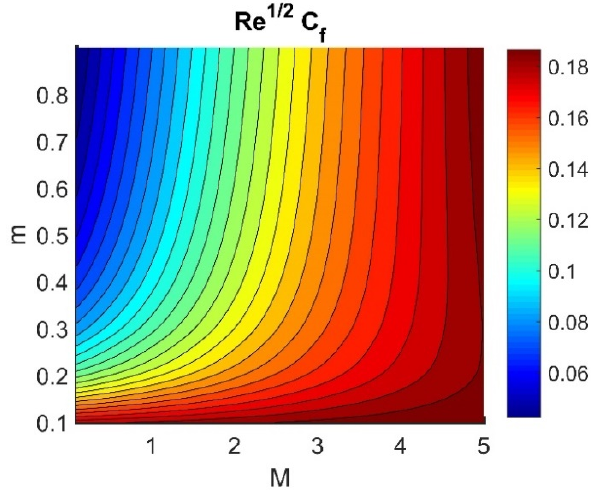
Figure 26. Impact of M and m on Re 1/2 C